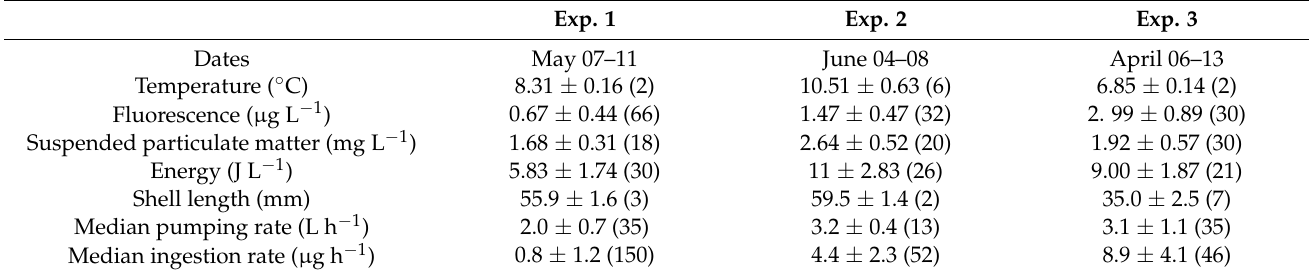
Table 1. Summary of environmental and M. edulis physiology data from all experiments. Values represent the mean for environmental data and the median for physiological data. ± indicates standard deviation, and the coefficient of variation (%) is shown in parentheses. Exp. 1 Exp. 2 Exp.